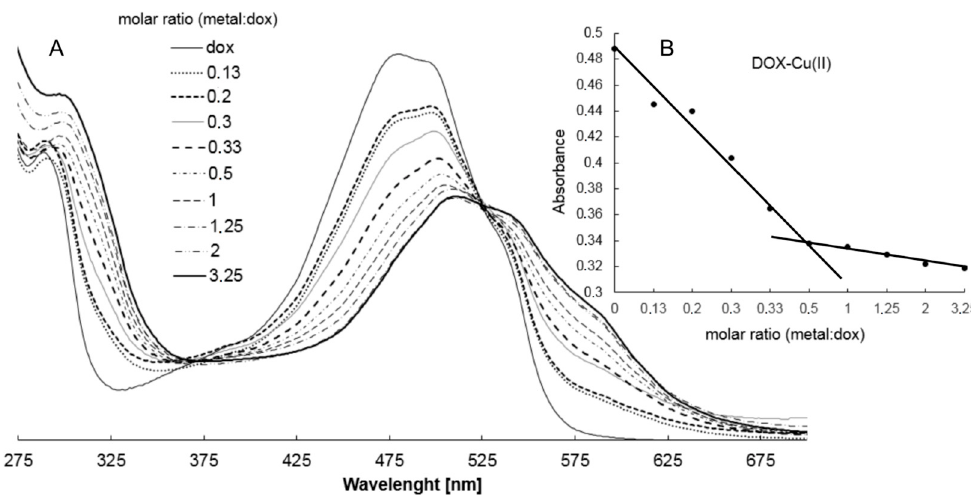
Figure 3. ( A ) Absorption spectra of DOX in the presence of various amounts of Cu(II) in Tris-HCl buffer pH 7.01 (different types of lines are labeled with a molar ratio Cu(II):DOX 0.13–2.0); ( B ) absorbance as a function of [Cu(II)]:[DOX] molar ratio at 500 nm.